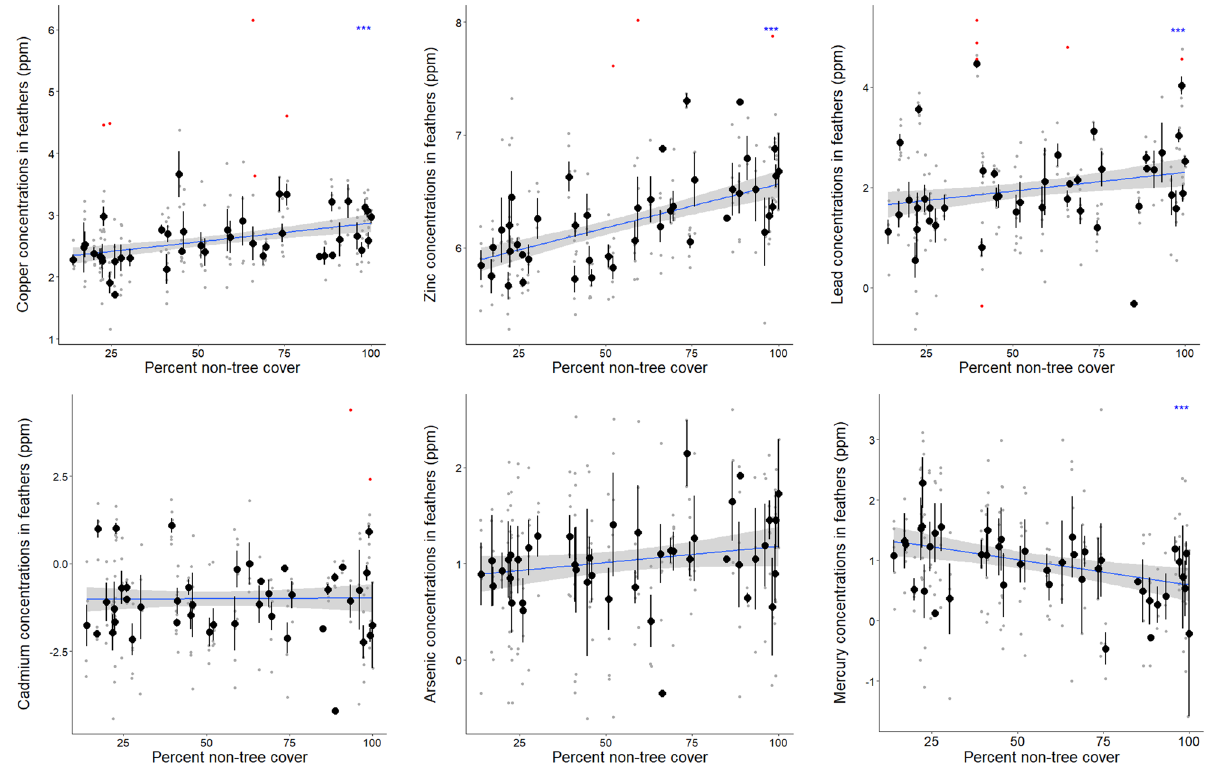
Figure 3. Relationship between MTE concentrations (i.e. Cu, Zn, Pb, Cd, As or Hg after log-transformation; in ppm) and the urbanization level (here tree cover). For the x axis to positively correlates with the urbanization level, we highlight the percent of non-tree cover (100—percent of tree cover). We highlight the concentration for each single individual (grey dots), the concentrations that were considered as outliers (in red), the mean ± se concentration per percent of non-tree cover (in black) and the regression line (in blue) and its confidence interval (in grey). The statistical significance of the relationship is highlighted with asterisks. Species-specific and age-specific relationships between MTE concentrations and the urbanization level are displayed in Figs. C1 and C2, respectively. Cu Zn Pb Cd As Hg 2 = 39.87, Habitat X P <